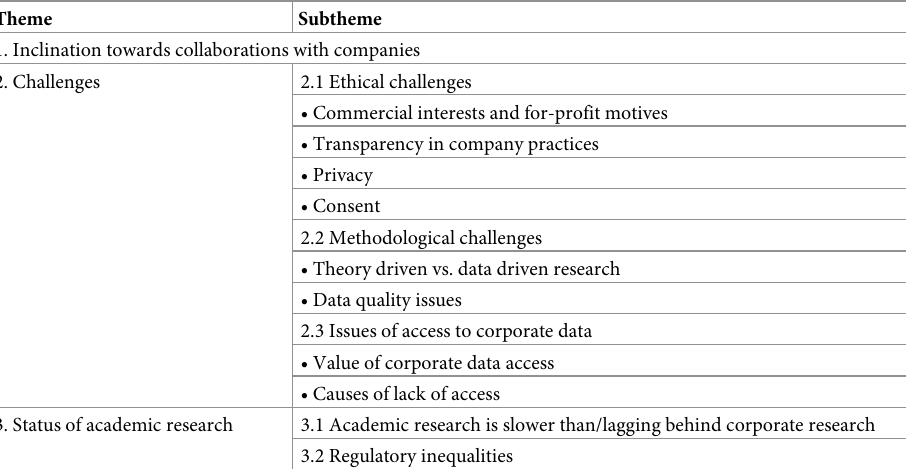
Table 5. List of themes and